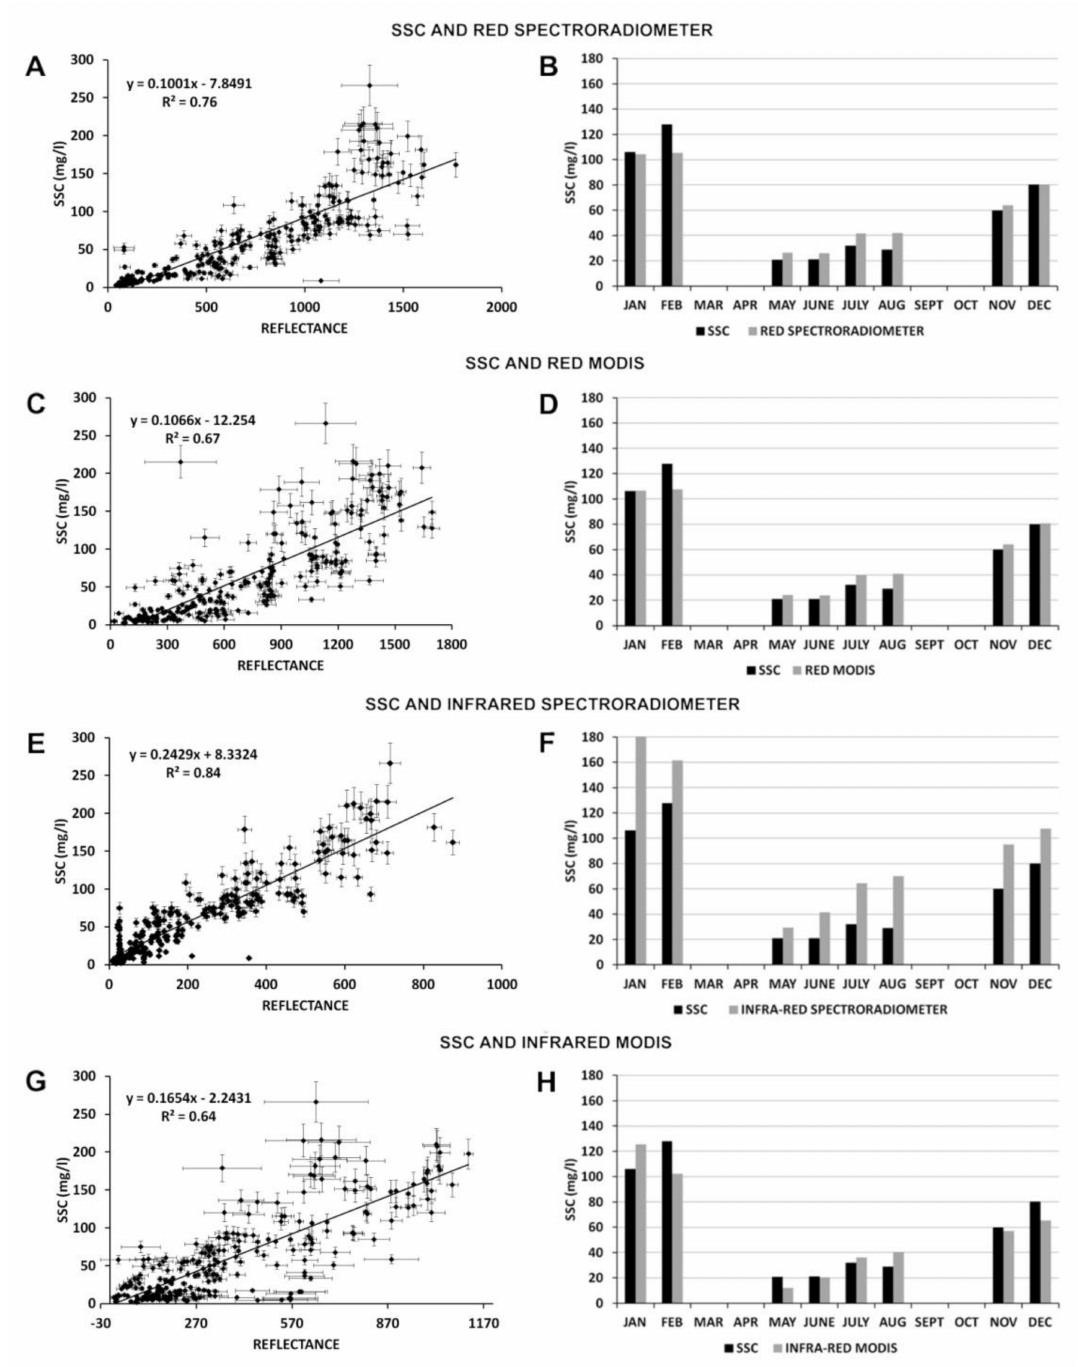
Figure 3. To red band: ( A ) Relationship between reflectance and SSC for spectroradiometer; ( B ) Mean monthly of SSC obtained by MODIS image to red band; ( C ) Relationship between reflectance and SSC for MODIS image; ( D ) Mean monthly of SSC obtained by MODIS image to red band; To infrared band: ( E ) Relationship between reflectance and SSC for spectroradiometer; ( F ) Mean monthly of SSC obtained by MODIS image to infrared band; ( G ) Relationship between reflectance and SSC for MODIS image; ( H ) Mean monthly of SSC obtained by MODIS image to infrared